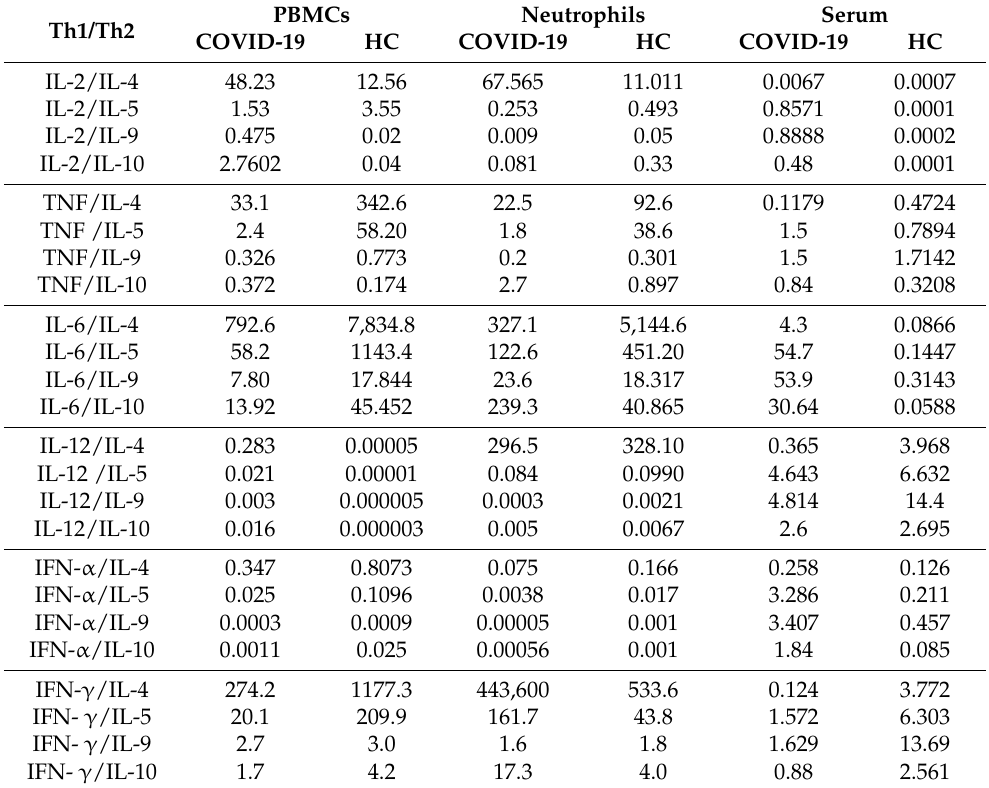
Table 4. Ratios of pro-inflammatory to anti-inflammatory cytokines in COVID-19 ICU patients and healthy